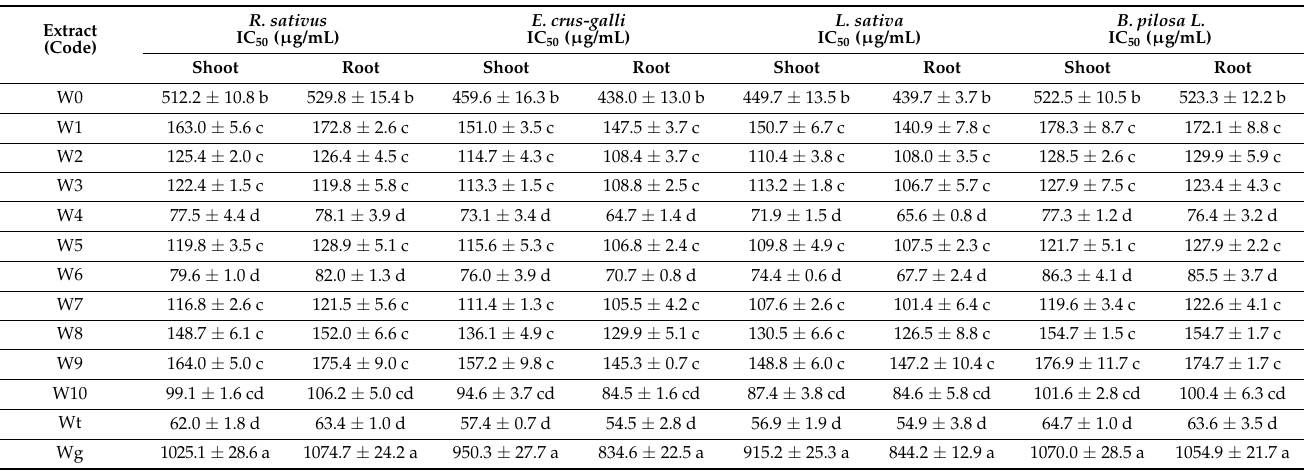
Values represent means ± SD (standard deviation). Alphabetic letters indicate statistical symbols generated by one-way ANOVA using Duncan’s test ( α = 5%). Values with similar letters in each column are not significantly different ( p < 0.05) ( n =